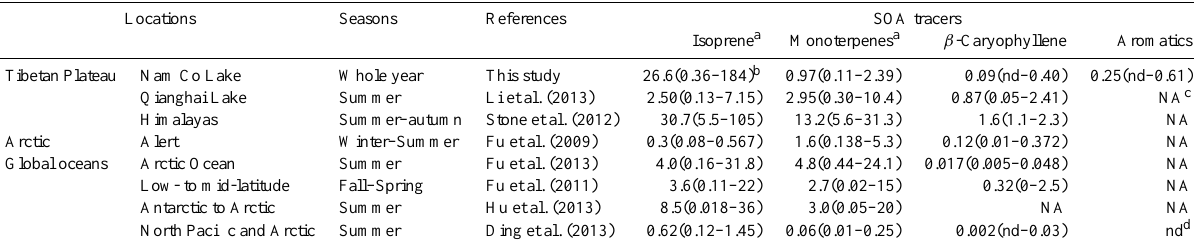
Table 2. SOA tracers in remote places on the global range (ngm − 3 ).